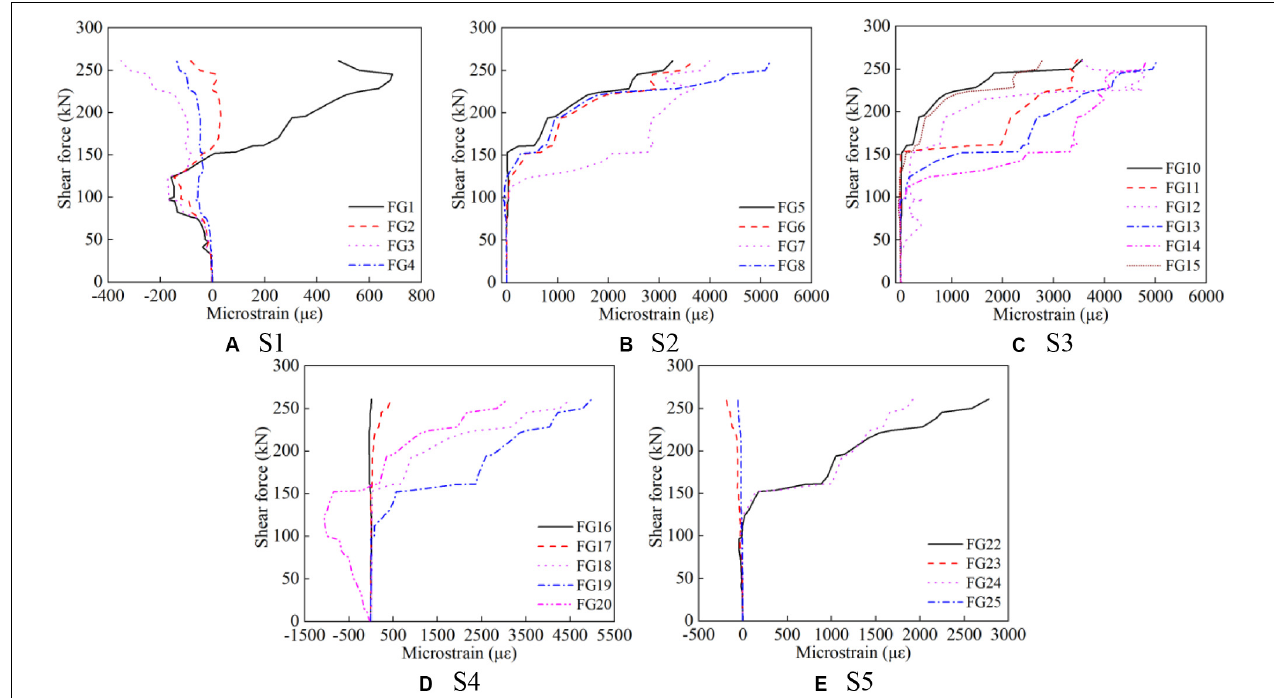
FIGURE 8 | Strain development in CFRP strips for EB-1-0. (A) S1, (B) S2, (C) S3, (D) S4, and (E) S5.